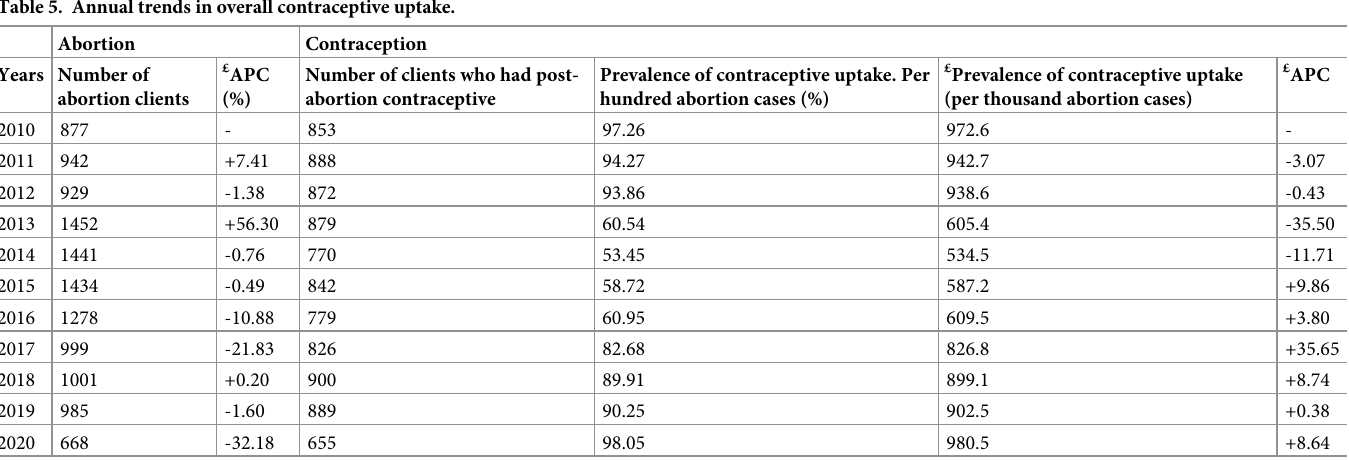
Table 5. Annual trends in overall contraceptive